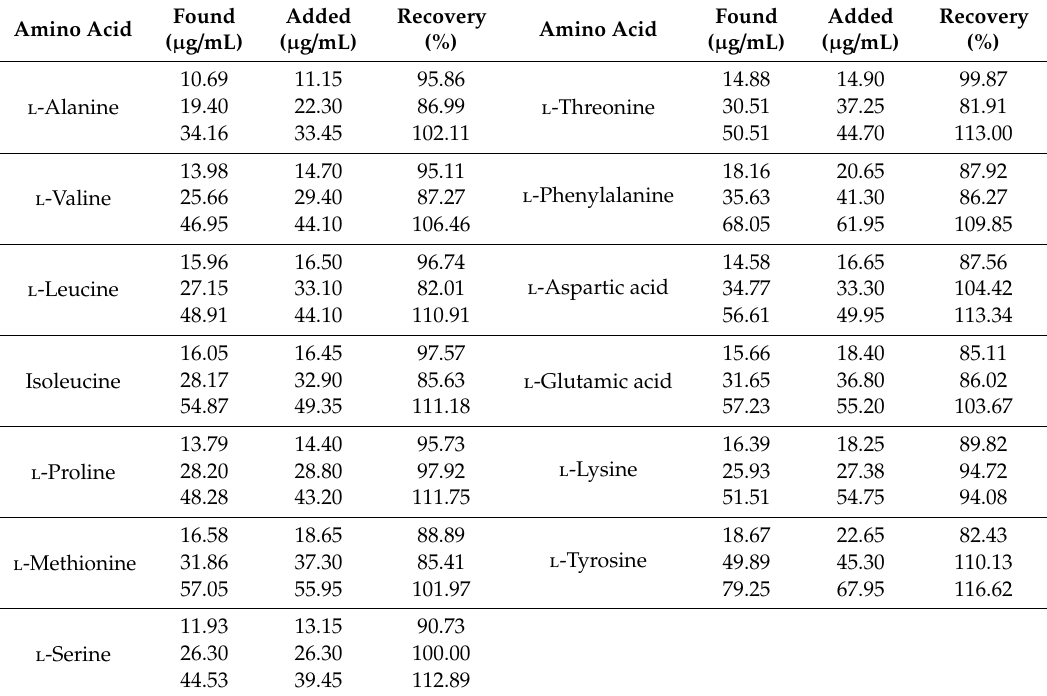
Table 4. Accuracy of GC–MS